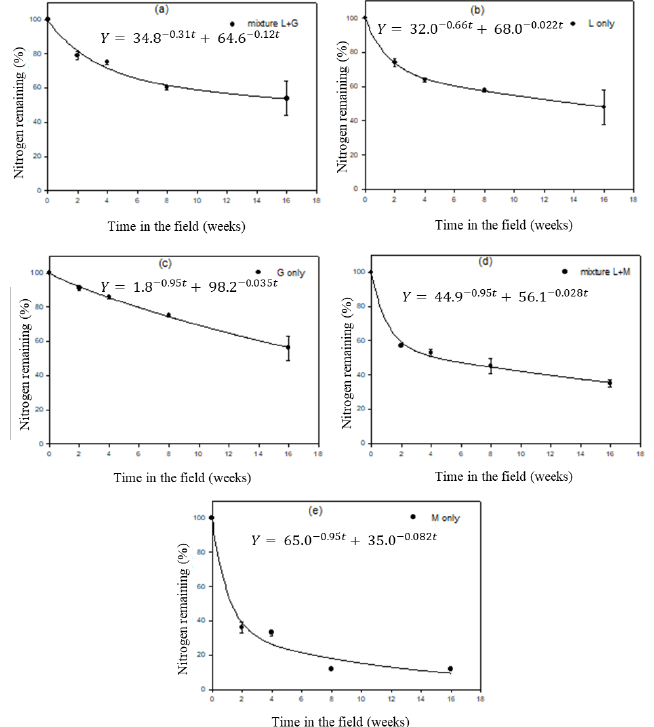
Figure 7. Modeled and measured nitrogen from decomposing leaves (( a ) = Leucaena + Guazuma , ( b ) = Leucaena , ( c ) = Guazuma , ( d ) = Leucaena + Moringa , ( e ) = Moringa ) for the wet period. Bars are SE.